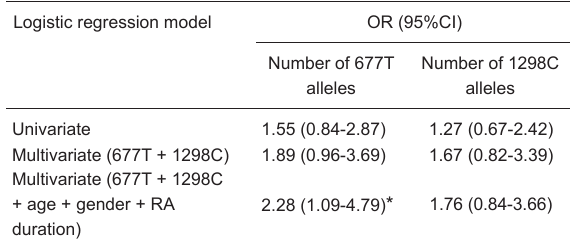
Table 3. Univariate and multivariate logistic regression models predicting odds ratios for patients’ response to treatment in rela- tion to 677C>T and 1298A>C genotypes.